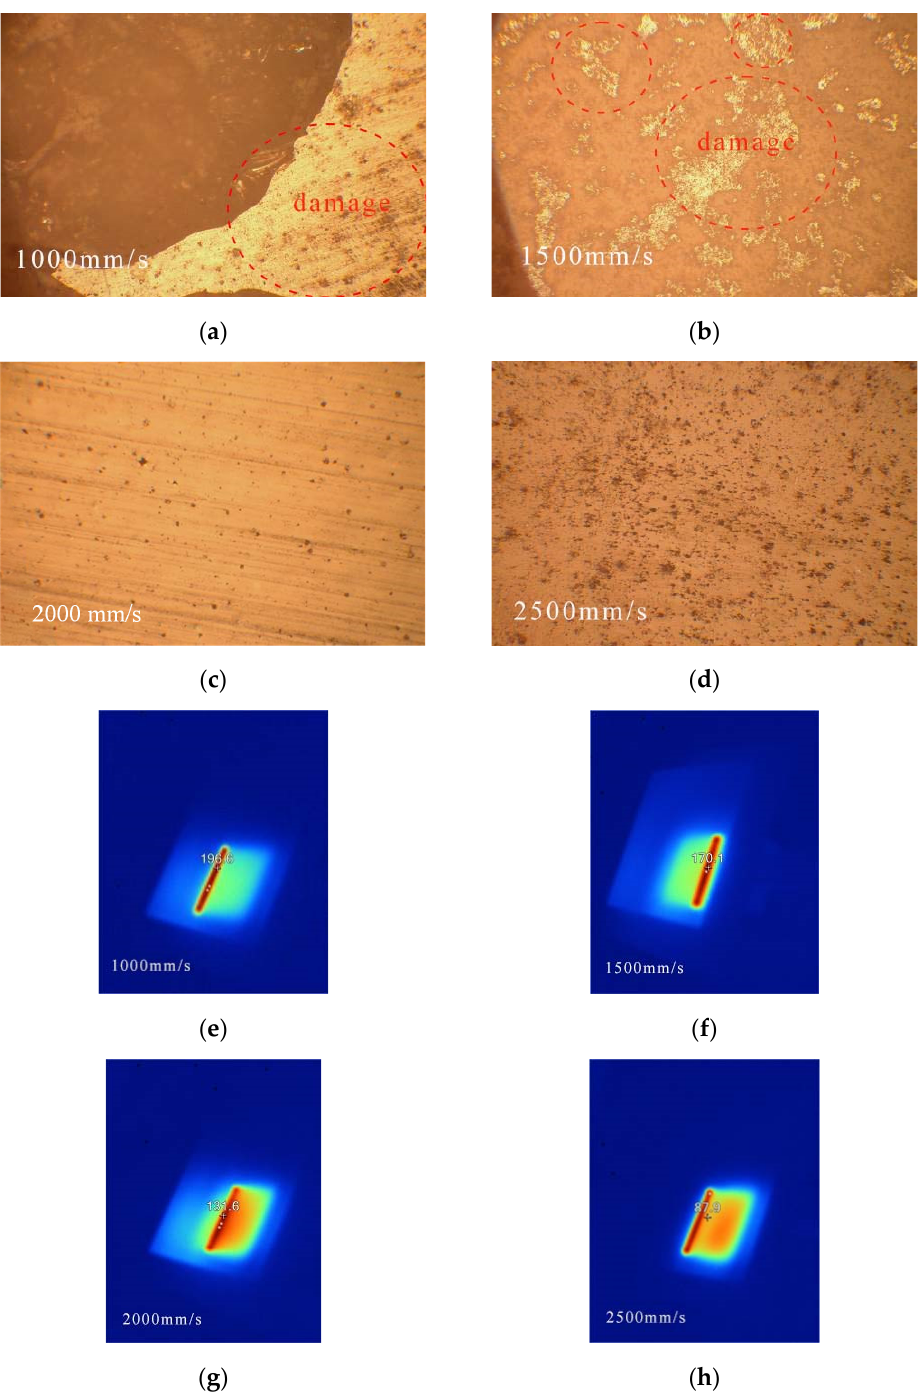
Figure 10. Cleaning e ff ect and Infrared temperature distribution with di ff erent scanning speeds: ( a ) 1000 mm/s; ( b ) 1500 mm/s; ( c ) 2000 mm/s; ( d ) 2500 mm/s; ( e ) 1000 mm/s; ( f ) 1500 mm/s; ( g ) 2000 mm/s; ( h ) 2500 mm/s.